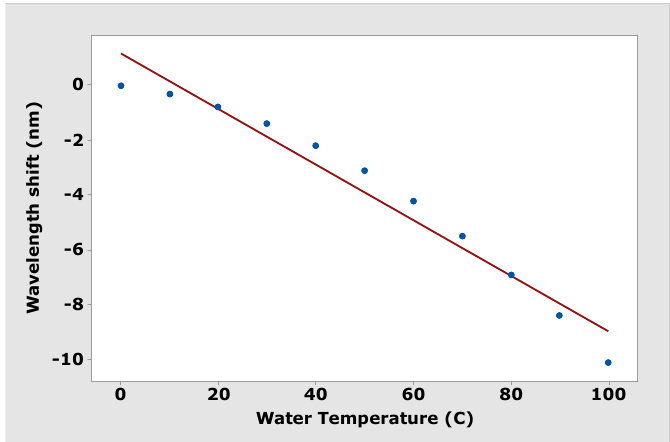
Figure 9. Peak wavelength shift as function of water temperature degree ( ◦ C) for a deformed photonic structure with 50 alternated layers of fused silica and TiO 2 and with a middle cavity filled with seawater at 35% salt level.